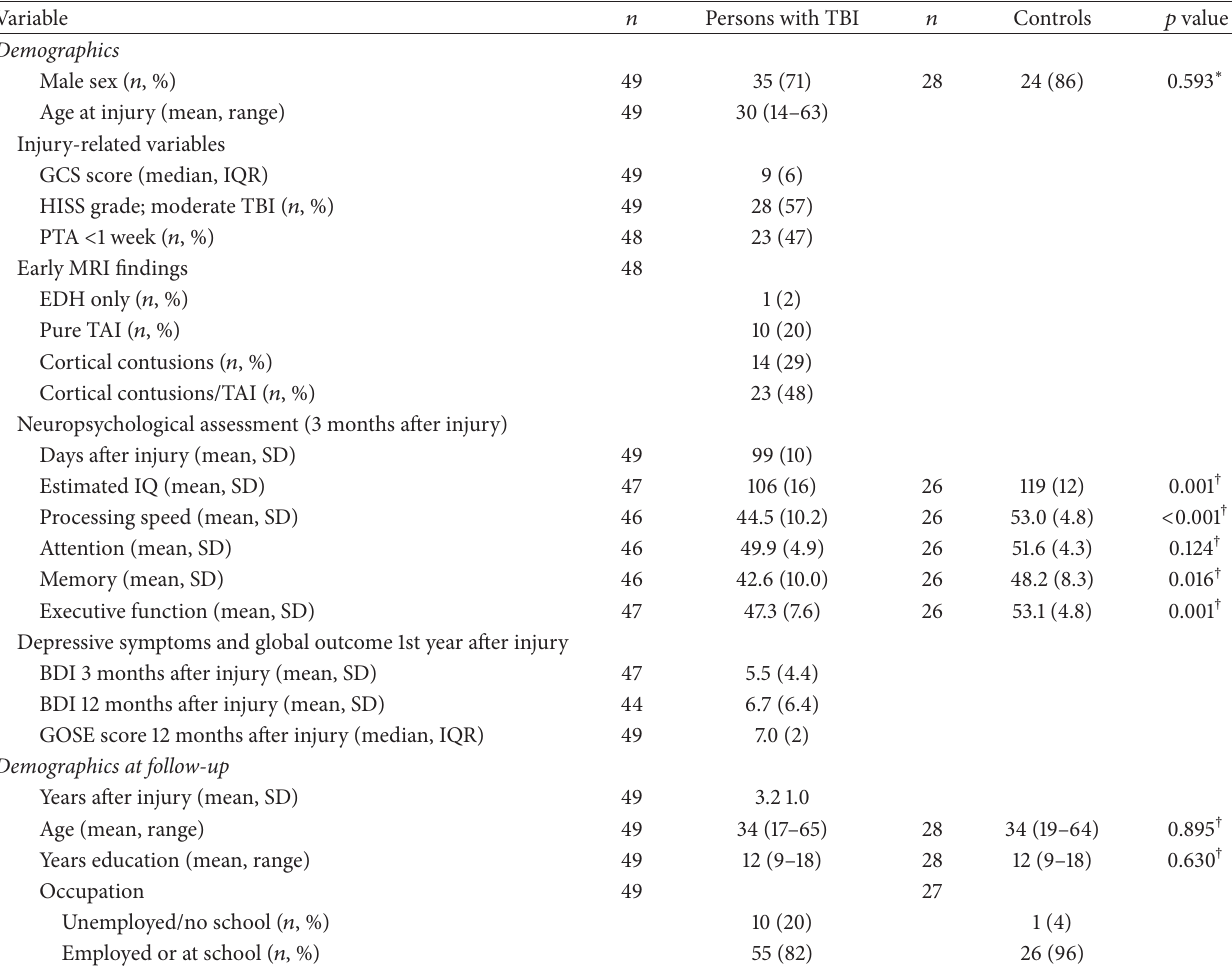
Table 7: Description of participants in the subgroup analysis: demographics, injury severity characteristics, and clinical observations at 3 months, 1 year, and 2–5 years after moderate and severe TBI: cognitive function, emotional function, global outcome, and employment.